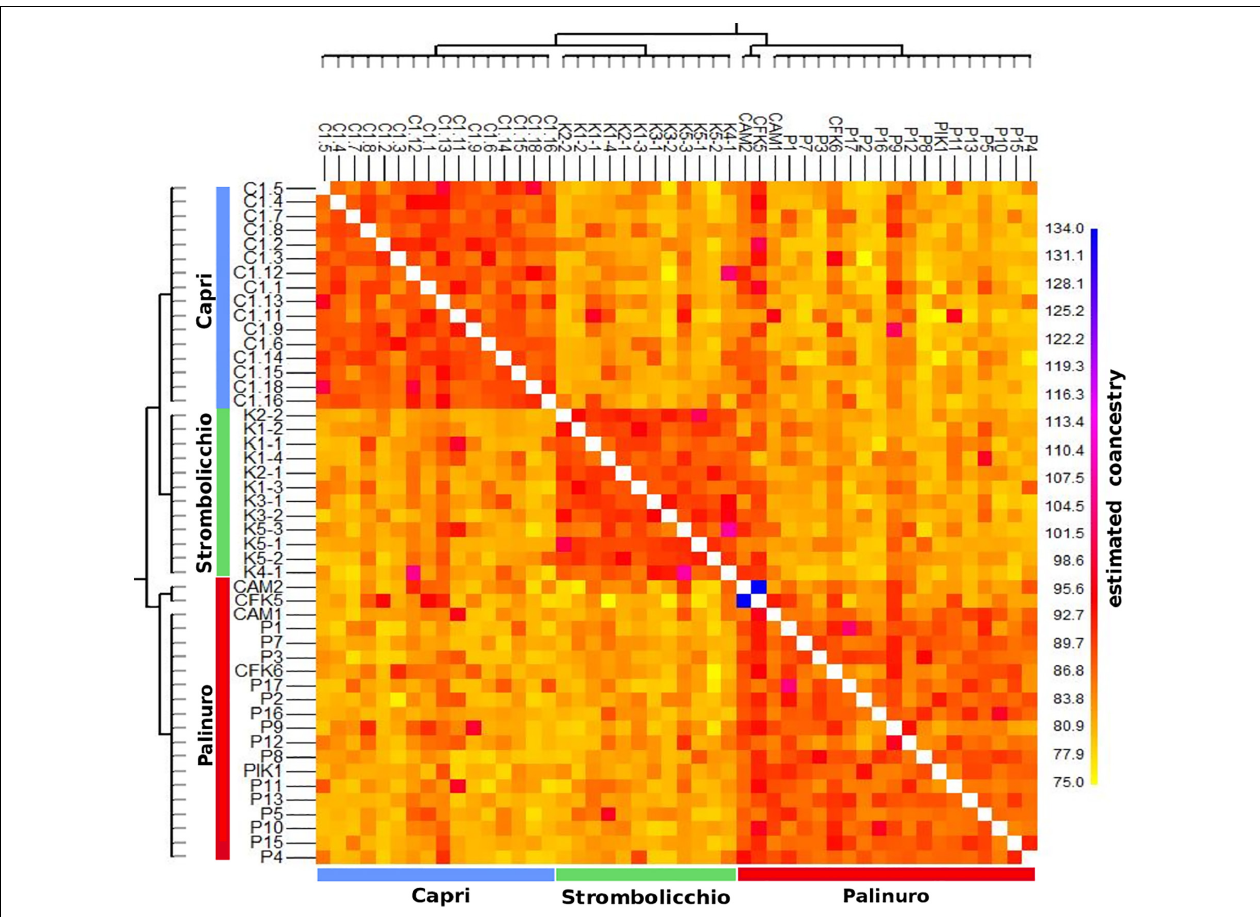
FIGURE 5 | The co-ancestry matrix was shared among 48 individuals (SNPs present in at least 70% individuals). The co-ancestry is calculated as the number of different sequences (i.e., SNPs) between pairs of individuals. The color of each cell in the matrix indicates the expected number of chunks imported from a donor genome (horizontal axis) into a recipient genome (vertical axis). Therefore, highly different cells are indicated in yellow, while indistinguishable cells are represented by blue/purple. Lastly, two phylogenetic trees with the Neighbor-Joining method are represented along the x and y axes.